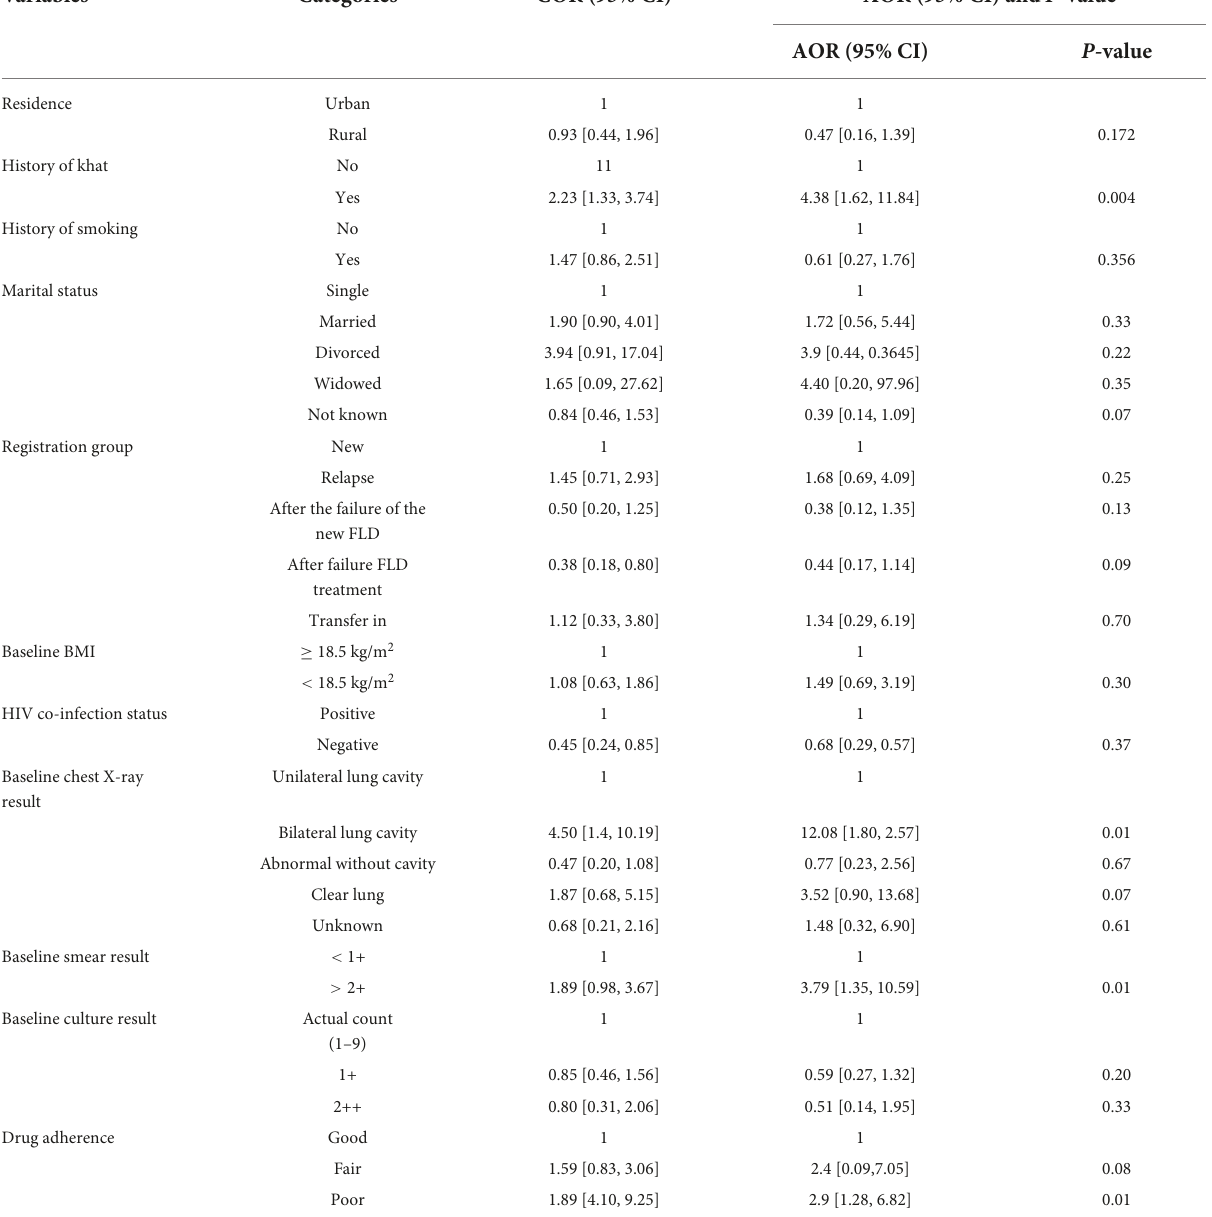
TABLE 6 Factors associated with treatment outcome among DR-TB patients eastern, Ethiopia